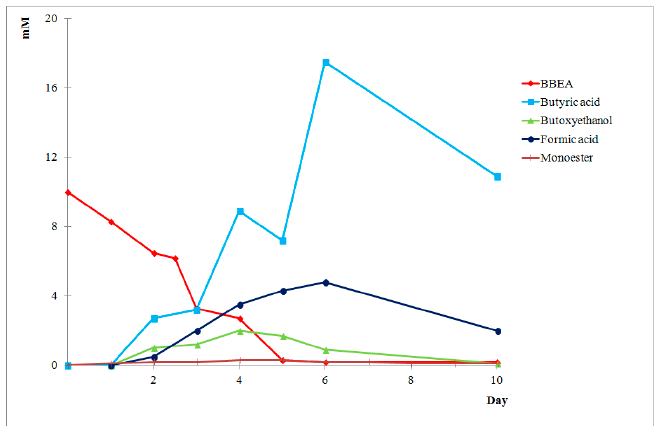
Figure 3. Biodegradation of BBEA in soil.